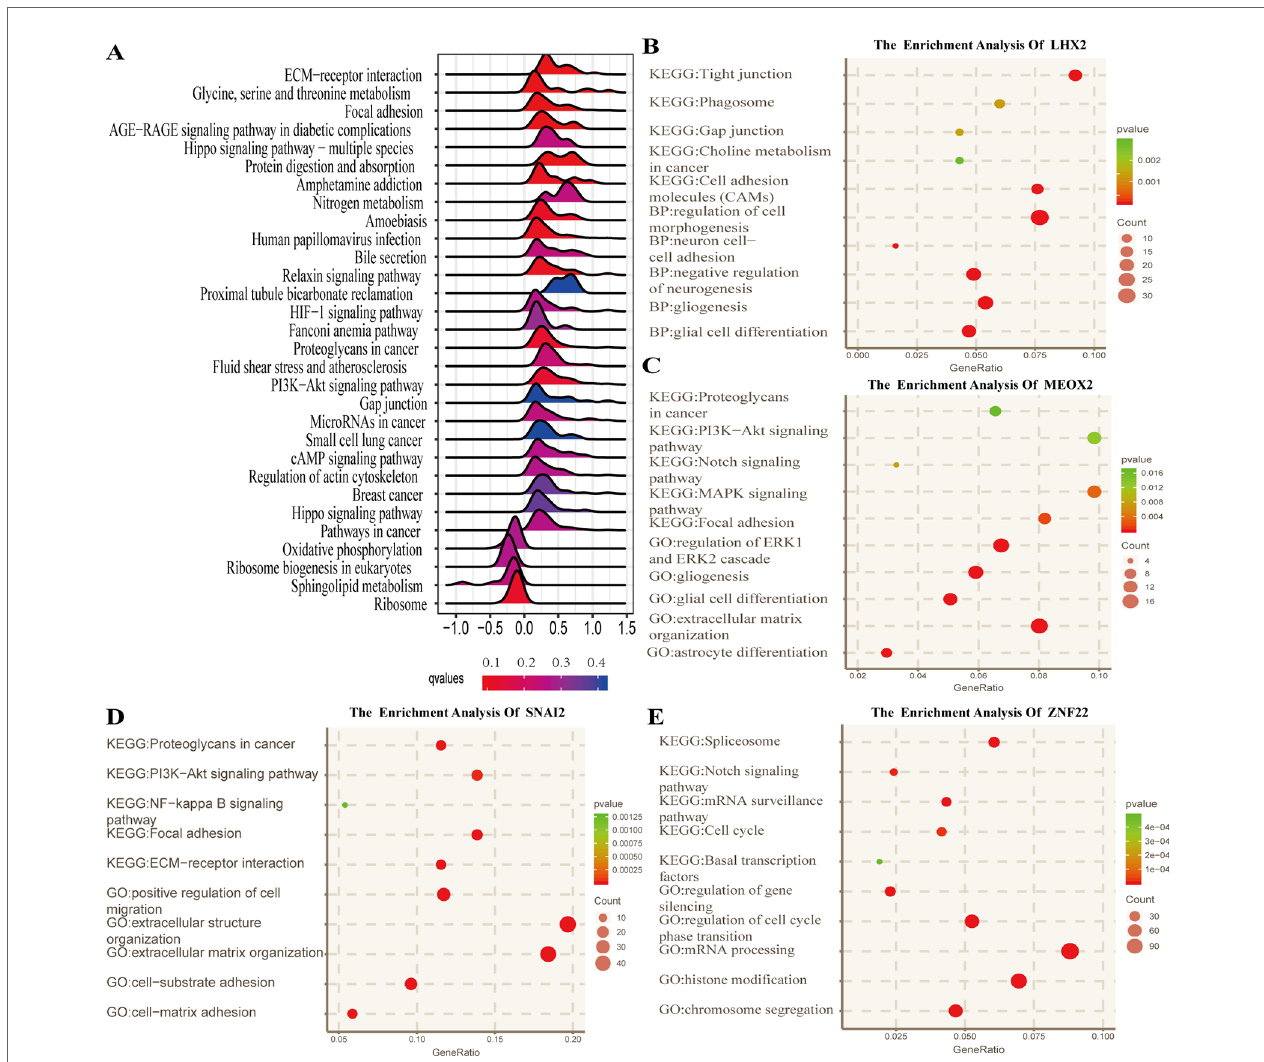
FiGURe 5 | Functional analysis for the prognostic classifier of genes. (A) Gene Set Enrichment Analysis (GSEA) based on risk score of transcription factors is performed to identify associated pathways in Kyoto Encyclopedia of Genes and Genomes (KEGG) gene sets. (B – e) Gene Ontology (GO) (biological process) terms and KEGG pathway related to co-expressed genes of LHX2, MEOX2, SNAI2, and ZNF22 in The Cancer Genome Atlas (TCGA)